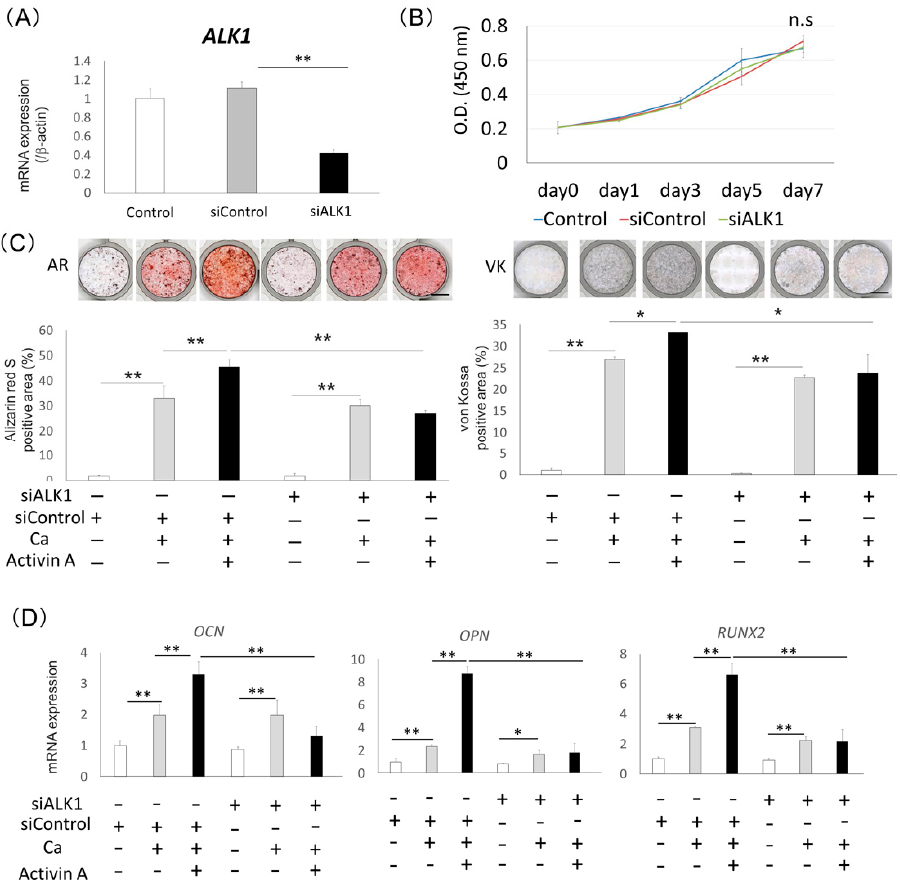
Figure 3. Treatment with siALK1 inhibited activin A-induced osteoblastic differentiation of Saos2 cells. ( A ) Gene expression of ALK1 in Saos2 cells with siALK1. Untreated cells were used as the control. Gene expression of ALK1 was analyzed using quantitative RT-PCR. Normalization of gene expression was performed against β -actin expression, and the gene expression levels were shown as the fold increase of the control. Values are the means ± SD from three independent experiments. ** p < 0.01. ( B ) Saos2 cells treated with siALK1 were cultured in 10%FBS/ α MEM for 0, 1, 3, 5 and 7